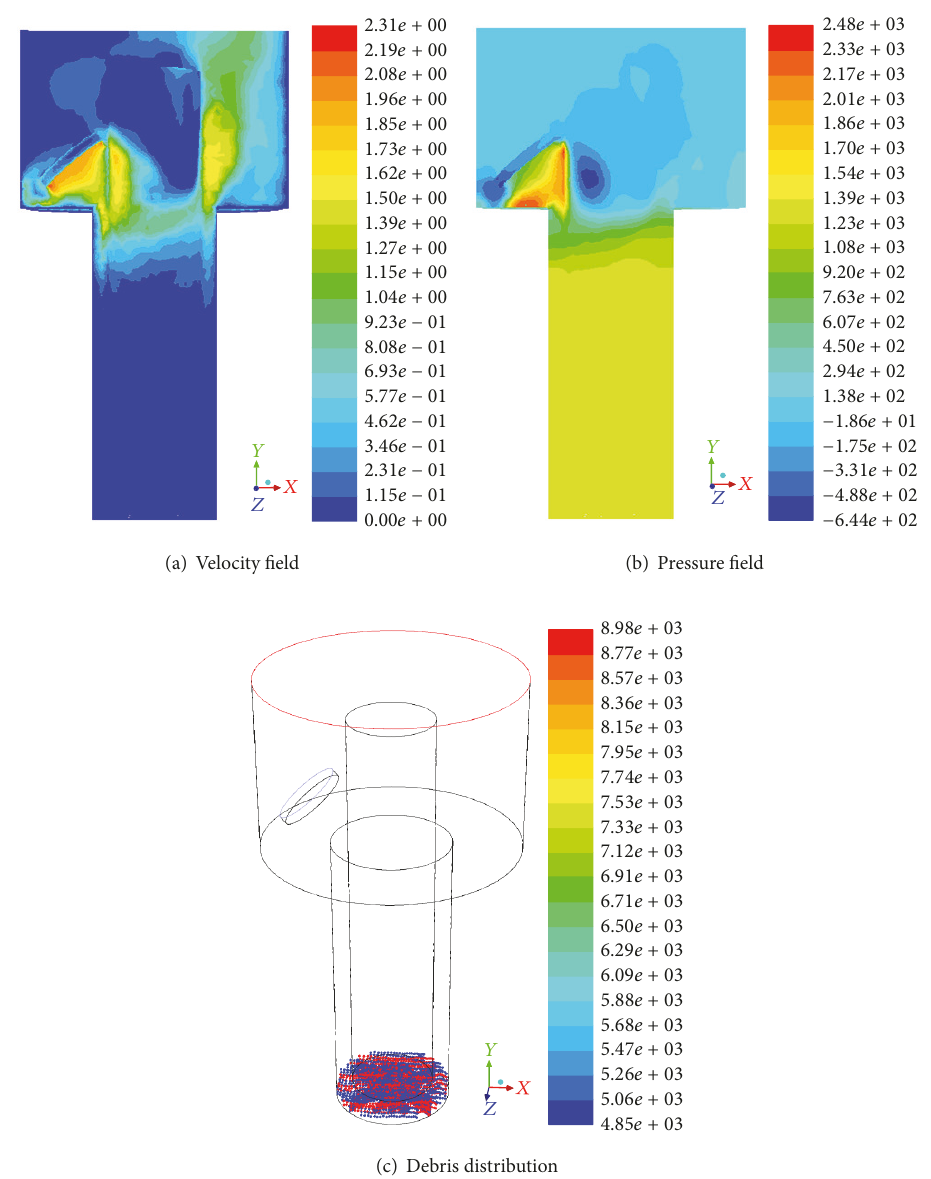
Figure 10: Schematics of gap flow field with flushing at 2m/s and 3.5 mm deep